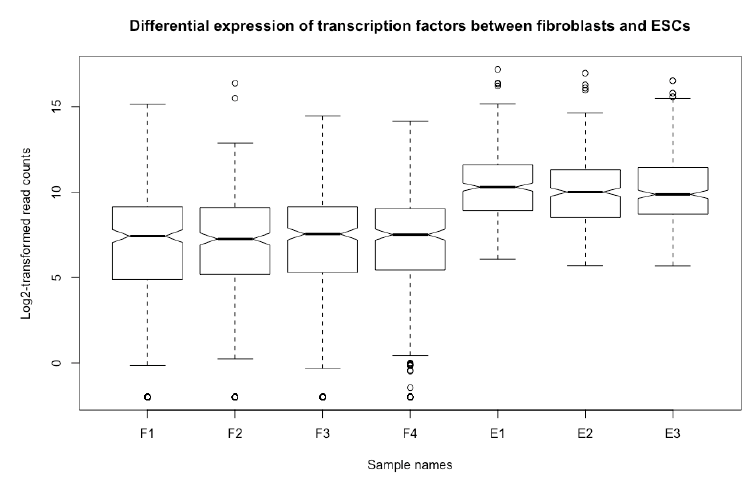
Figure 19. Add a figure title and annotation of axes.